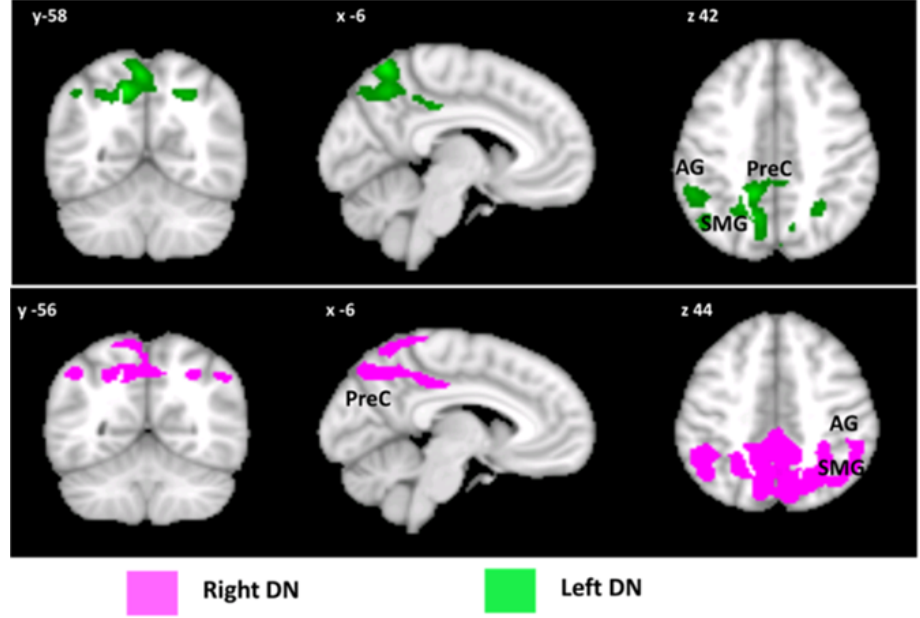
Figure 4. Patterns of DN FC with the cerebral cortex. Seed-to voxel patterns of increased right (violet) and left (green) DN FC with the cerebral cortex. Coronal (y), sagittal (x), and axial slices (z) in the Montreal Neurological Institute space. Clusters of increased FC in the cerebral cortex were considered significant after correction for multiple comparisons (FWE-corrected p < 0.05). Images are shown in neurological convention. AG: angular gyrus; SMG: supramarginal gyrus; Prec: precuneus. Table 3. Detailed statistics of voxel-wise comparison of cerebello-cerebral FC.